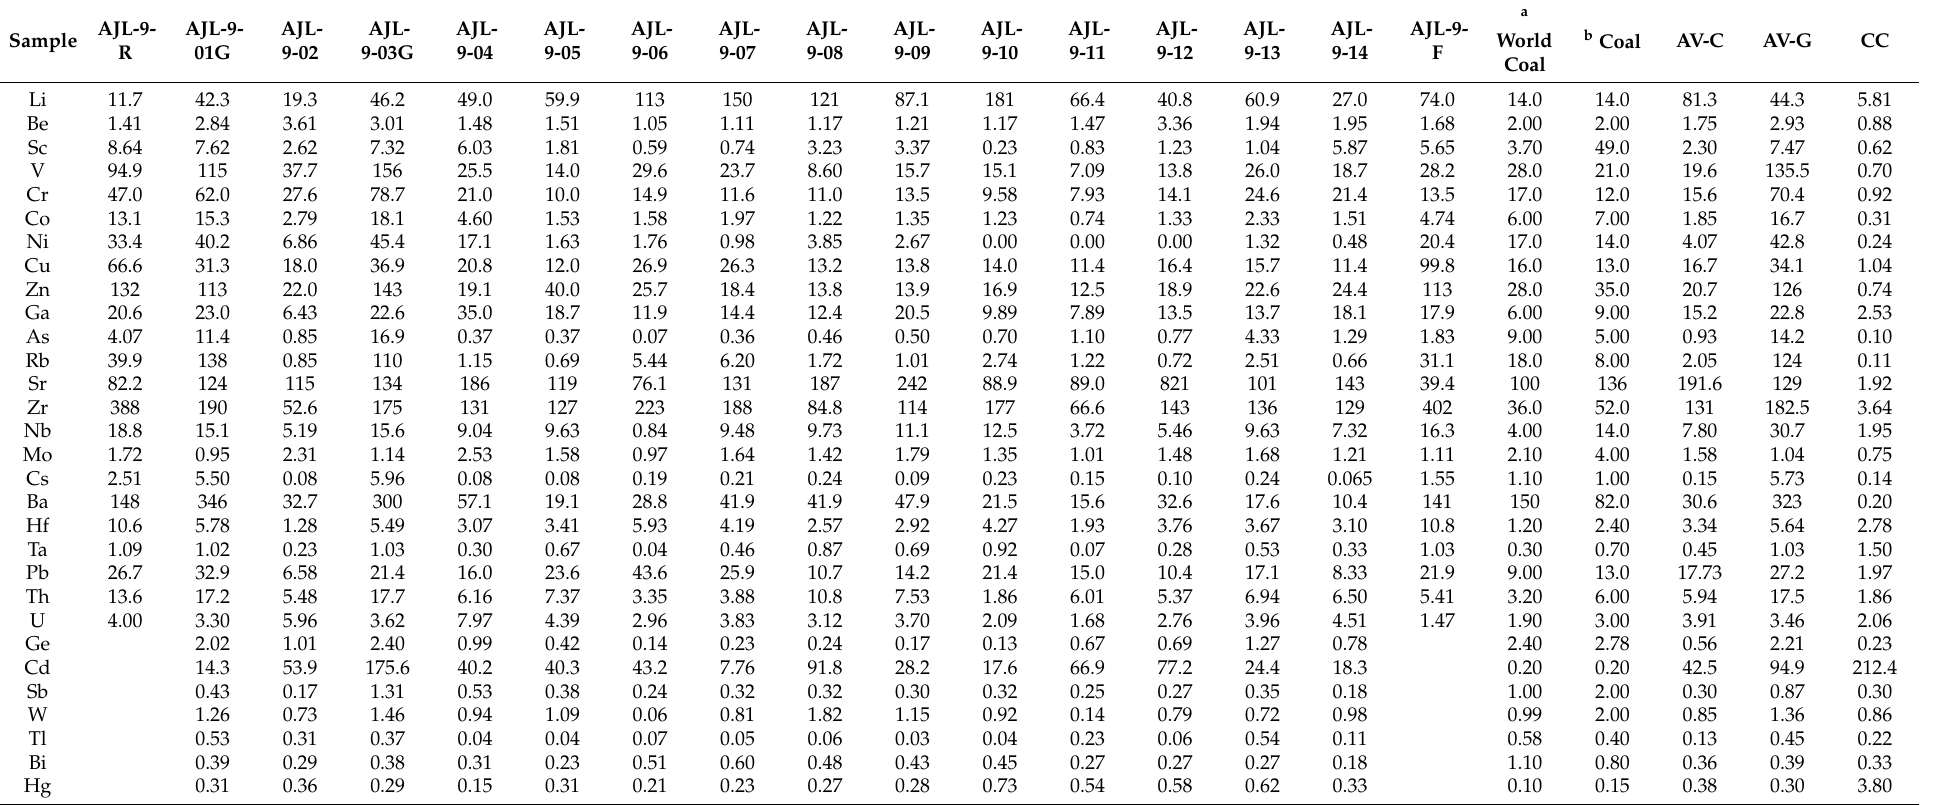
Table 3. The concentrations of trace elements ( µ g/g) in the coal from the Anjialing coal seam 9 and those in other hard coal from around the